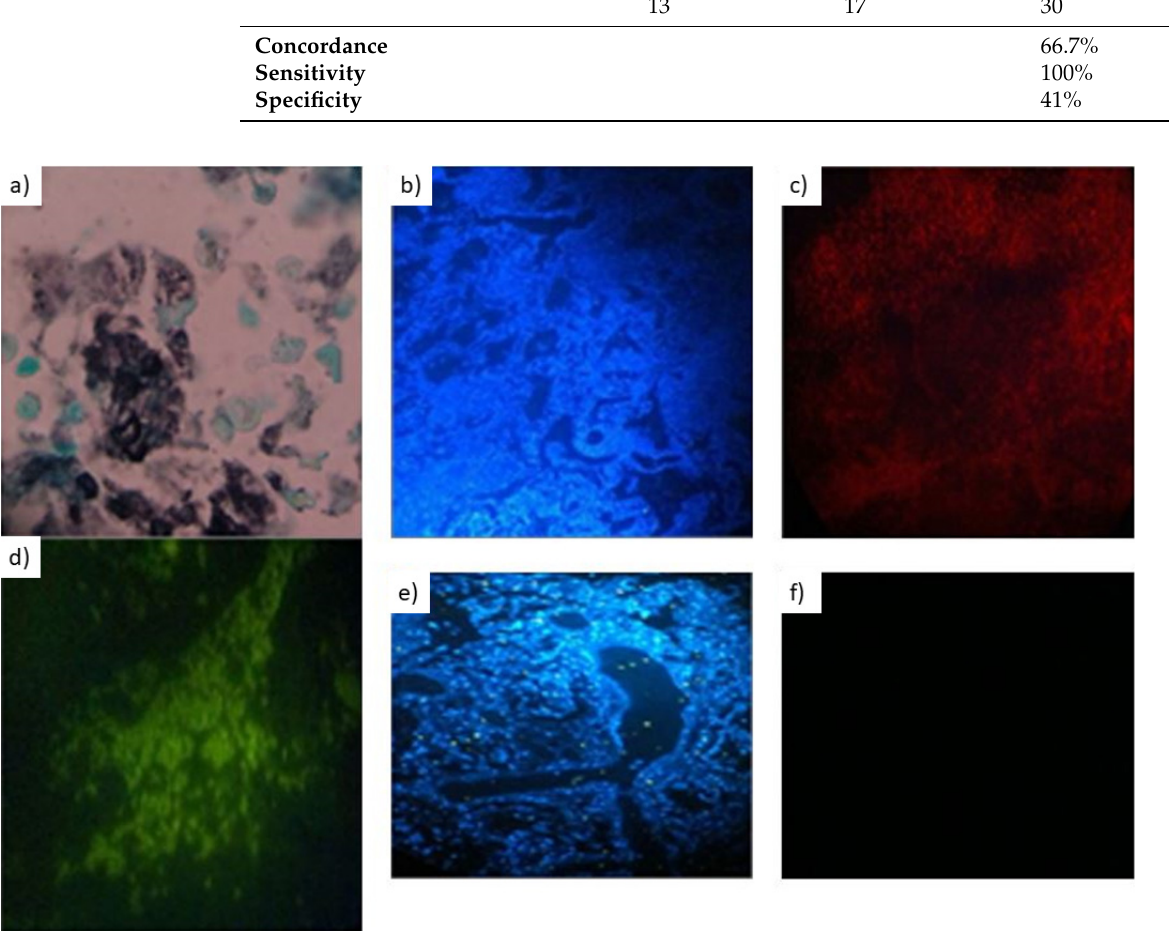
Figure 1. FISH staining results in paraffin-embedded tissue applying paneukayotic and P. jirovecii- specific FISH probe. Magnification 1000×. No size band available, so the 5–8 µm size of the Pneumocystis cysts serves as a size standard. The positive sample row—( a – d )—shows the staining with ( a ) Grocott’s stain (counterstained with Goldner’s stain III), ( b ) the DAPI dye visualized in blue, ( c ) the pan-eukaryotic probe visualized in red, and ( d ) the P. jirovecii probe visualized in green, respectively. Subsequently, the negative sample row—( e , f )—shows the staining ( e ) with the DAPI dye and ( f ) the P. jirovecii probe, respectively. On note, only cysts were